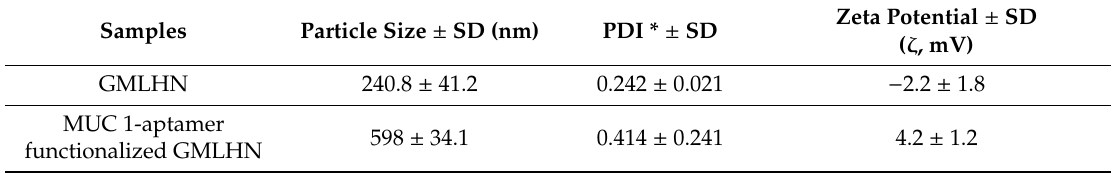
Figure 1. Nanoparticle characterization. ( A ) SEM microscopy of GMLHN showing the nanoparticles are spherical. ( B ) FT-IR spectra of GMLHN and MUC 1-aptamer confirming the covalent conjugation of aptamer to the nanoparticles. ( C ) Release profile of miRNA-29b from MUC 1-aptamer functionalized GMLHN at di ff erent pH values ( D ) Release profile of genistein from MUC 1-aptamer functionalized GMLHN at di ff erent pH values. Table 1. Particle size analysis by dynamic light scattering and net charge on nanoparticles .